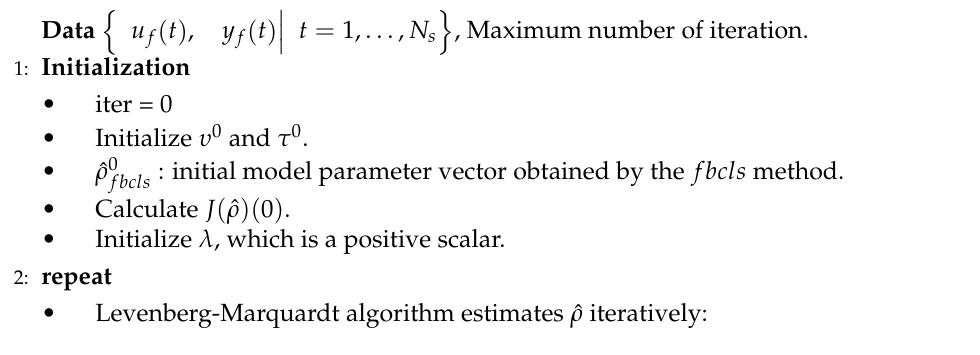
Algorithm 1 FSTD - OE